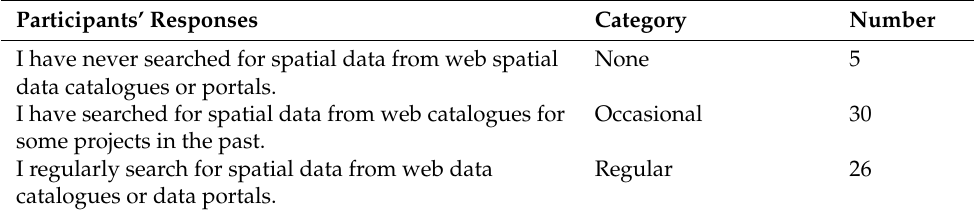
Table 4. Participants’ experience with spatial data portals or websites.